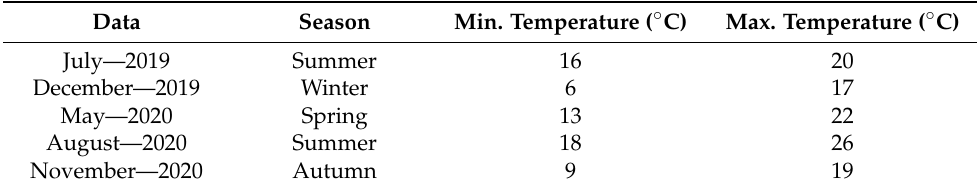
Table 1. Dates, seasons and respective air temperatures on the flight days.